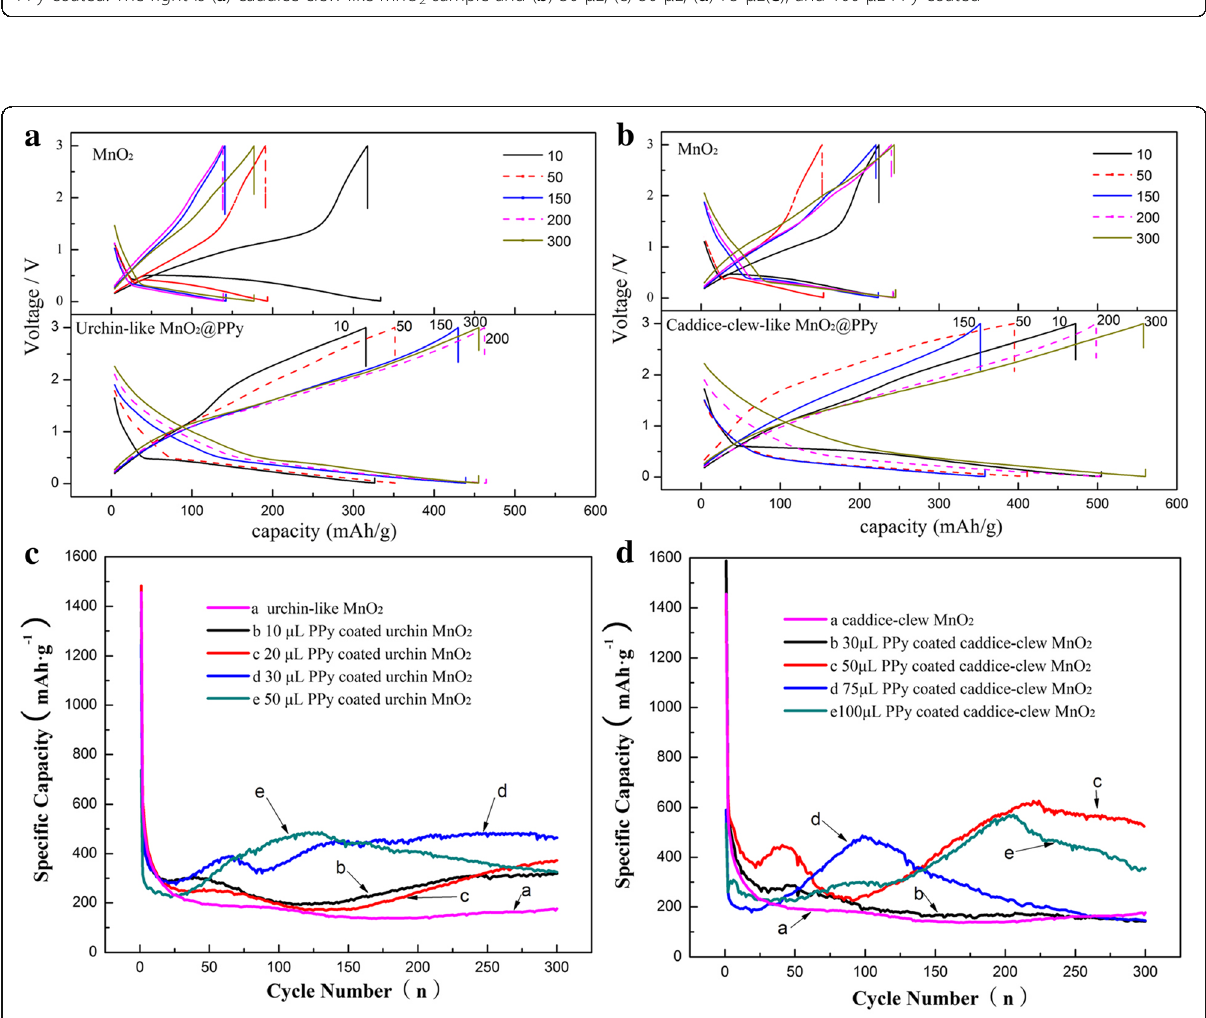
Fig. 6 a , b Charge-discharge curves for selected cycles of 30 μ L PPy-coated MnO2 sample and 50 μ L PPy-coated caddice-clew-like MnO2 sample. c , d The cycling performance of the MnO2 sample and PPy-coated MnO2